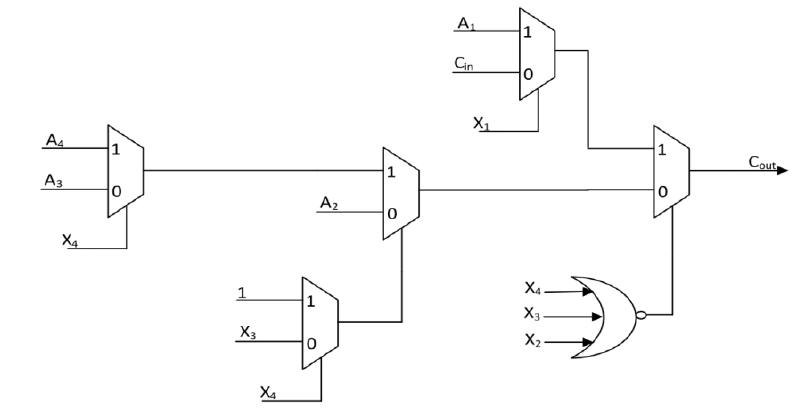
Figure 6. Proposed circuit for calculating output carry (i.e. fourth bit carry) .